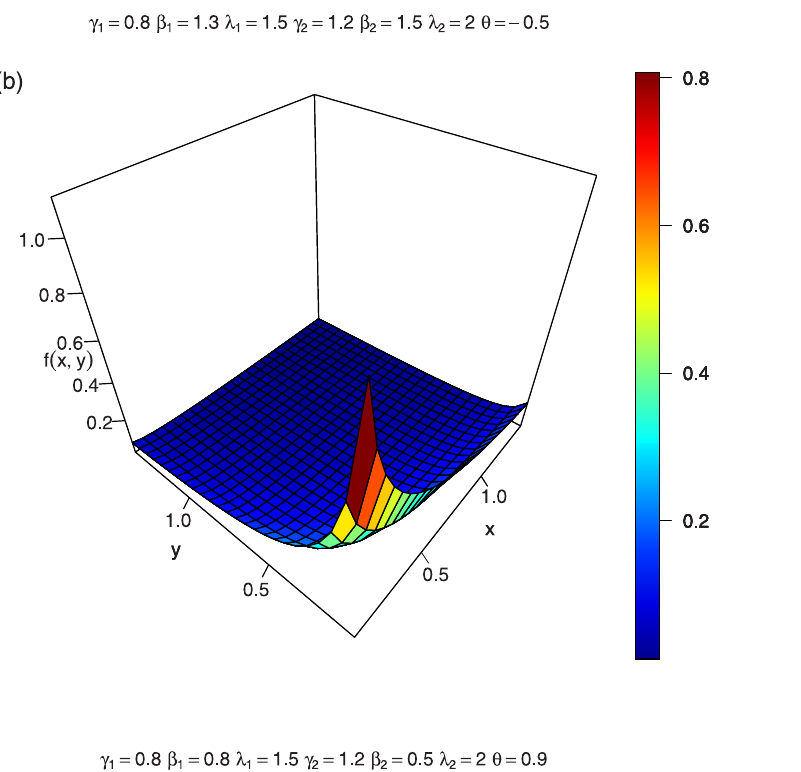
Fig 2. 3-dimension of joint density of